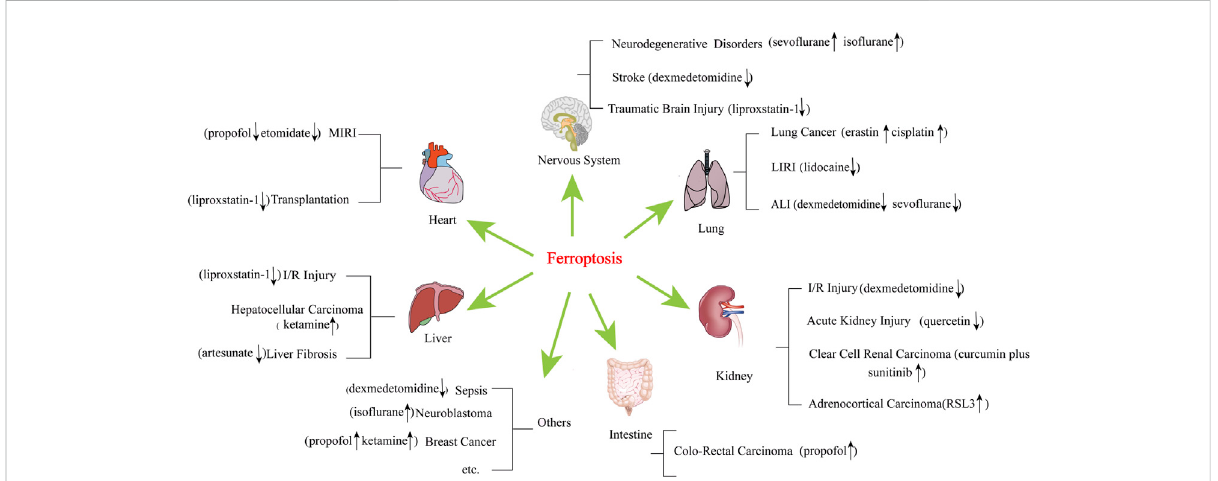
FIGURE 1 Diseases and narcotics are linked to ferroptosis. These diseases include acute lung injury, acute kidney injury, cancer, cardiovascular disease, neurodegenerative disease, and liver disease, among others. MIRI, myocardial ischaemia reperfusion injury; LIRI, lung ischaemia reperfusion injury; ALI, acute lung injury. “ ↑ ” represents promotion, “ ↓ ” represents